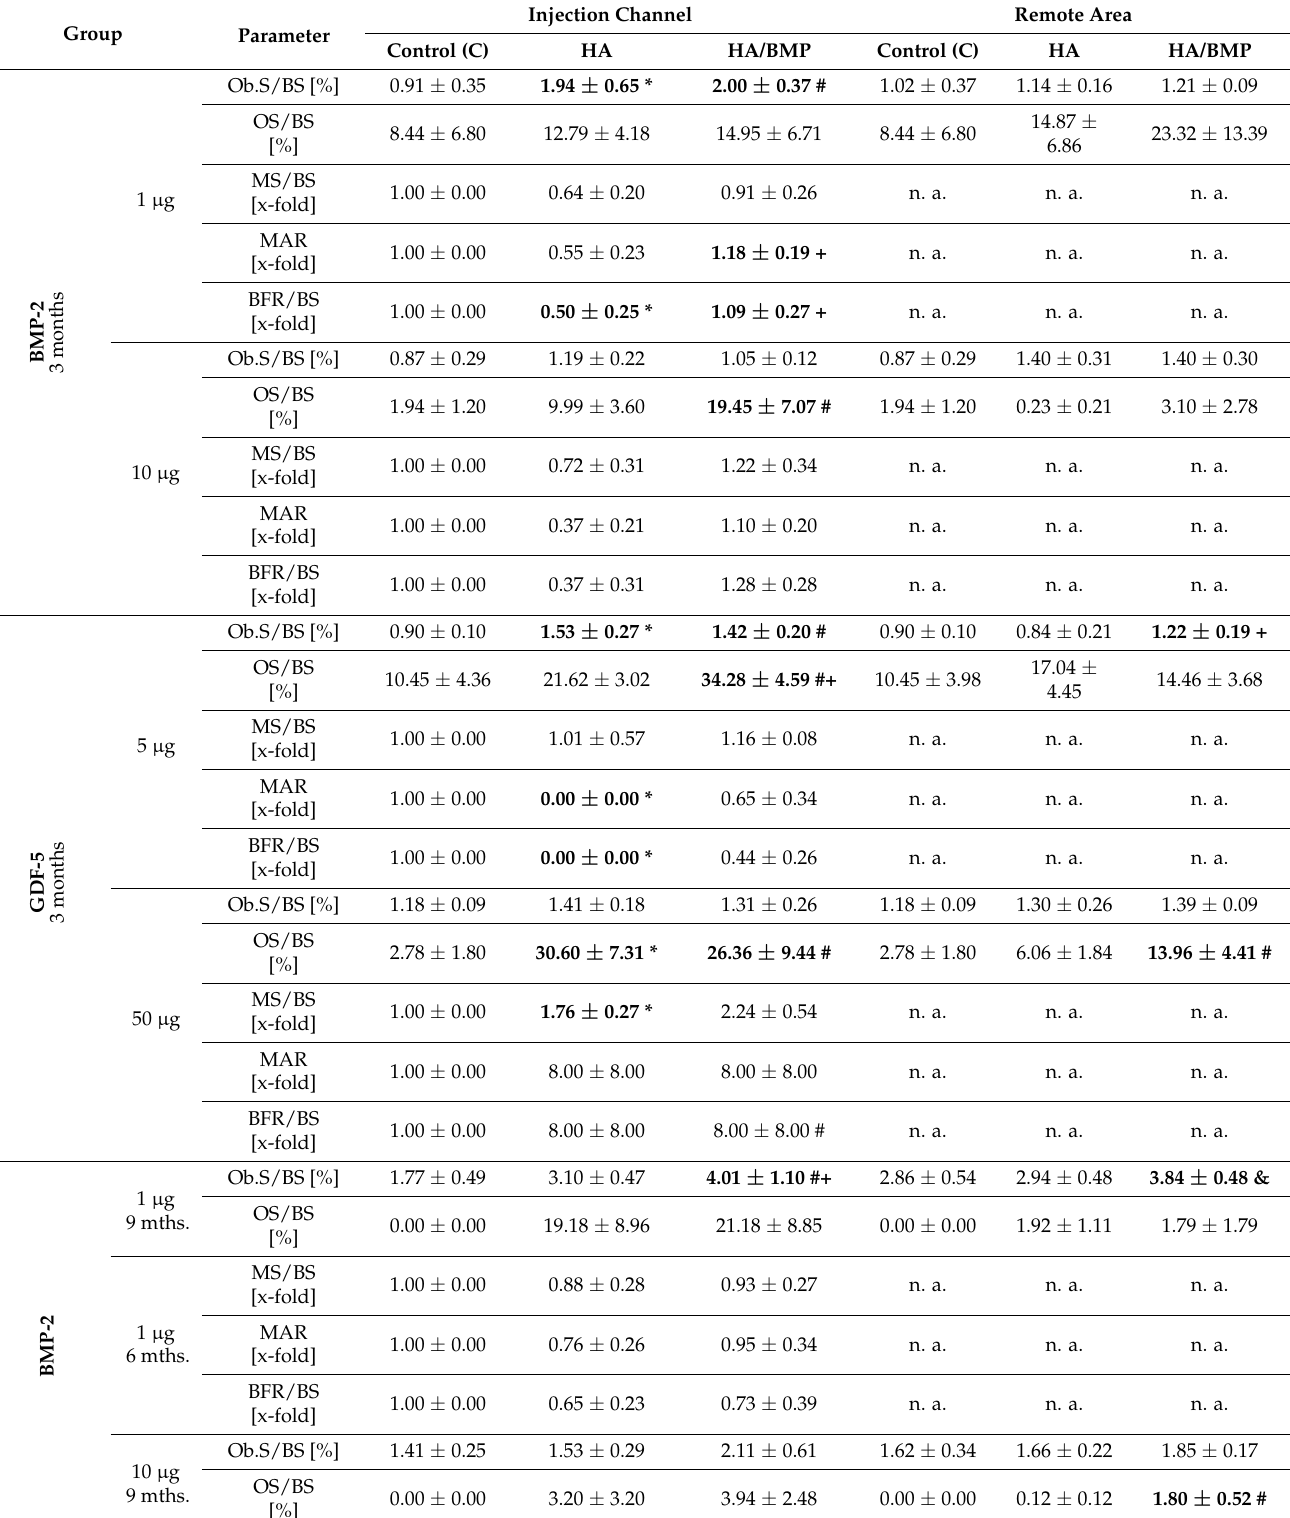
Table 3. Control, HA, and HA/BMP vertebral bodies grouped by BMP, dose, and